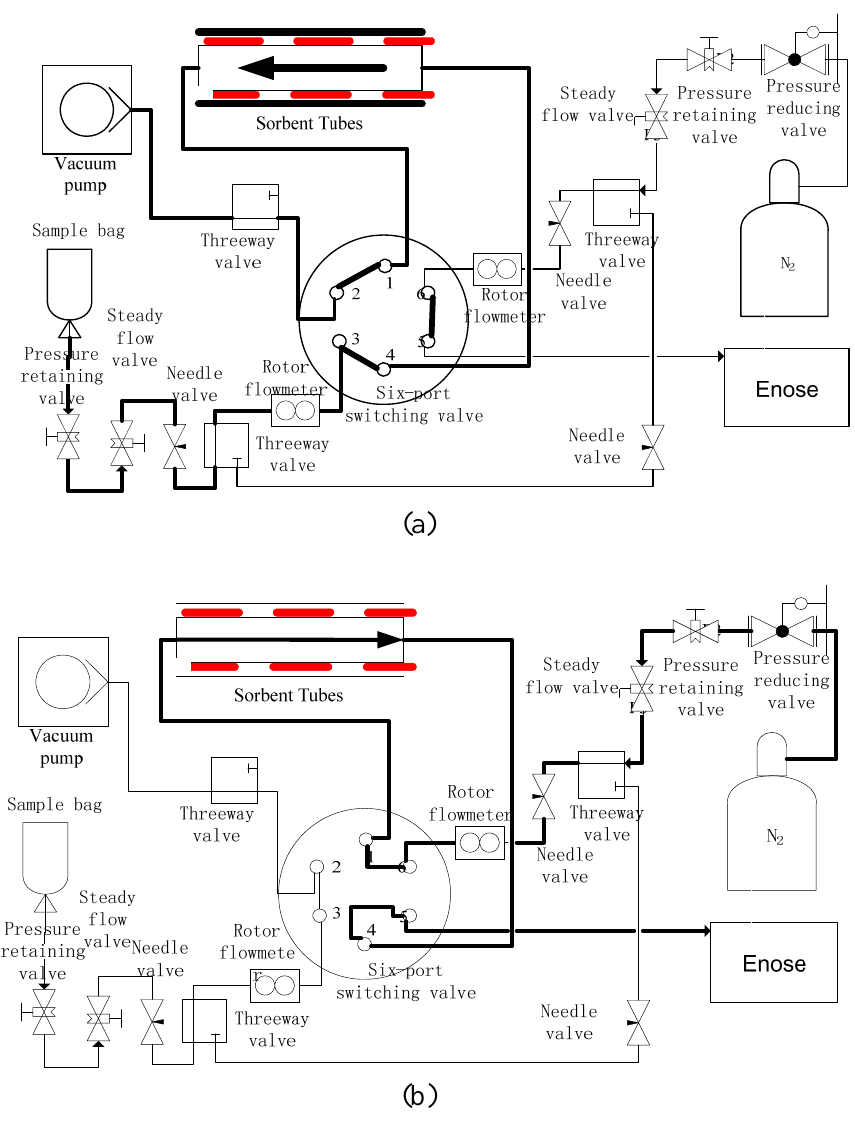
Figure 1. System layout of the pre-condensation for the e-nose. (a) Adsorption stage; (b) Desorption